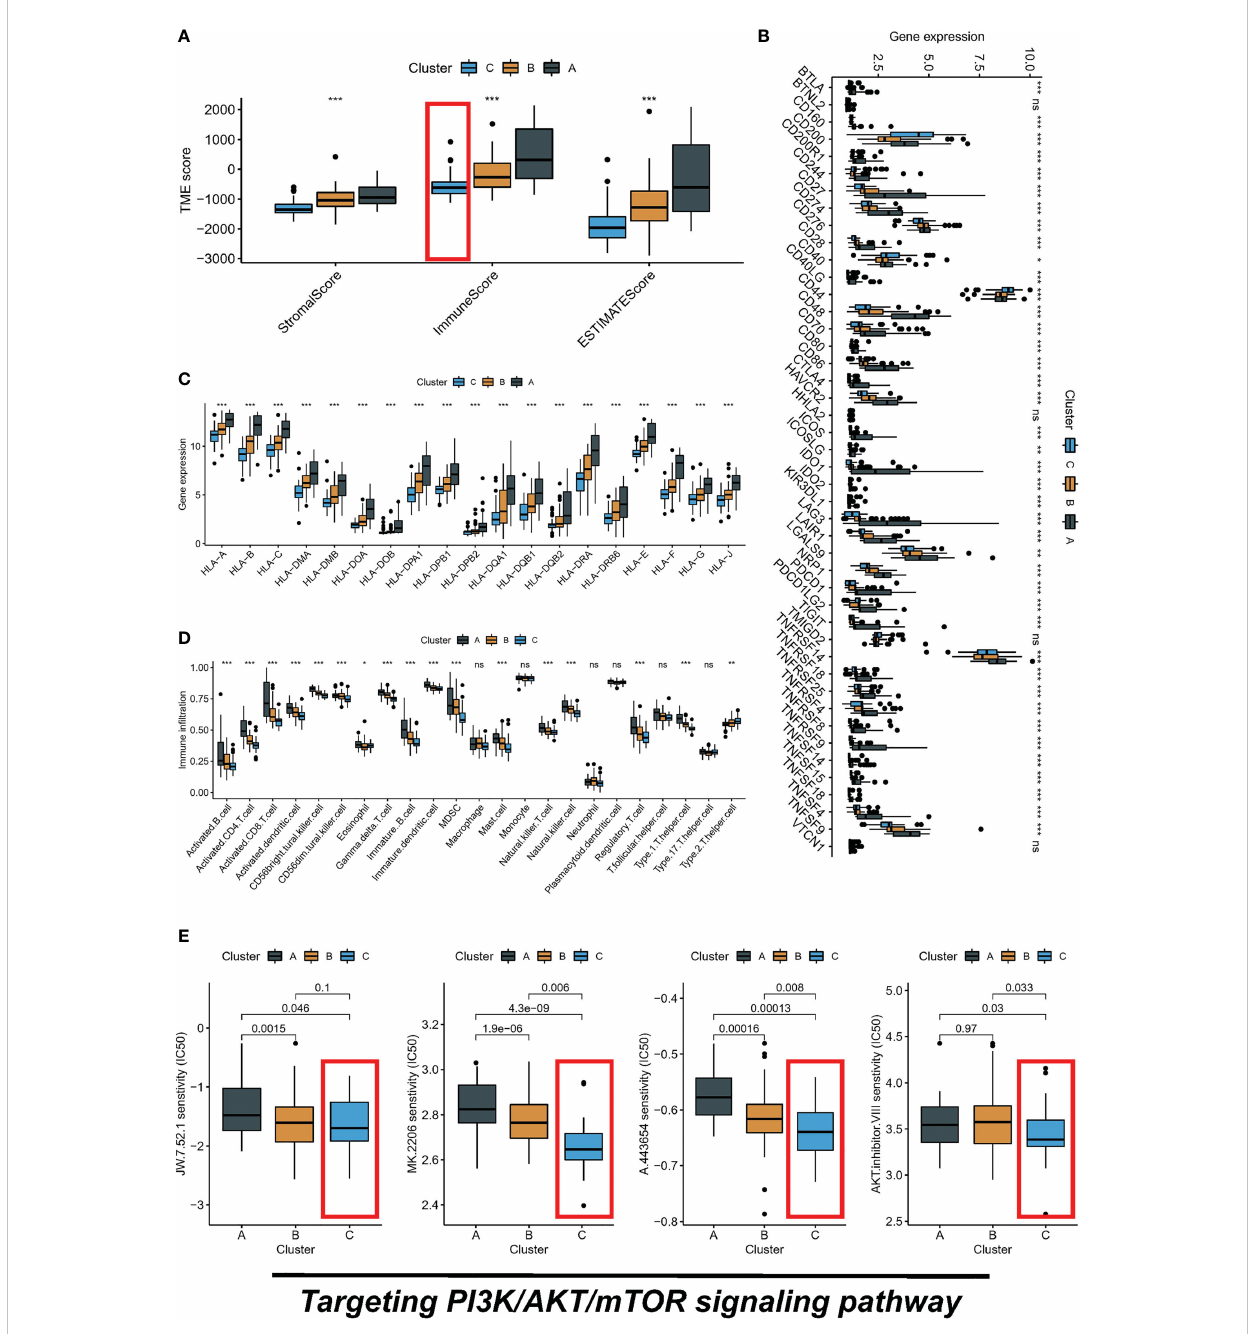
FIGURE 3 Three subtypes display different immune landscape and chemotherapy drug sensitivity. (A) The expression level of the immune score, stromal score, and ESTIMATE score, between different subtypes. (B) Comparison of immune checkpoint blockade-related genes expression levels in three subtypes. (C) Comparison of 19 HLA-related genes expression levels in three subtypes. (D) immune function by ssGSEA. (E) The boxplot of sensitivity of small molecule drugs targeting PI3K/AKT/mTOR between three subtypes. ns, not signi fi cant, * P < 0.05, ** P < 0.01, *** P <